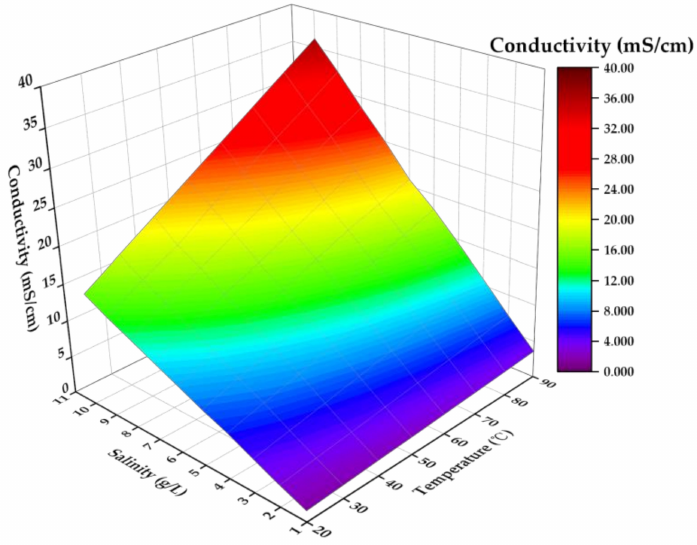
Figure 18. Relationship between salinity, temperature, and